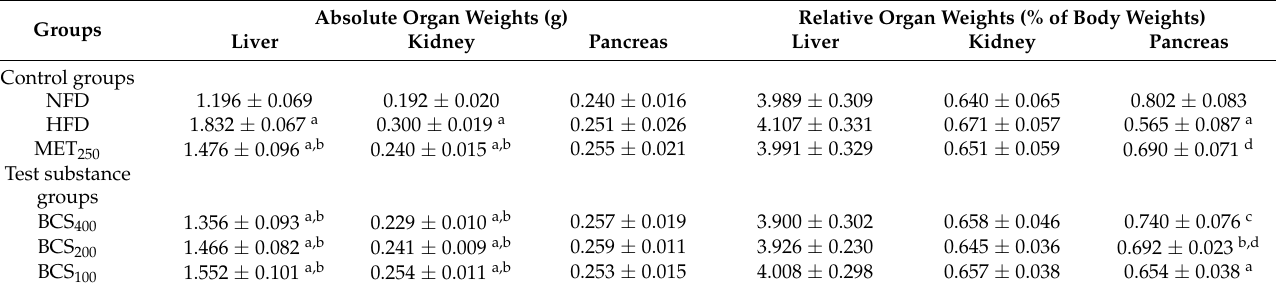
Table 5. Absolute and relative organ weights in HFD- and NFD-supplied